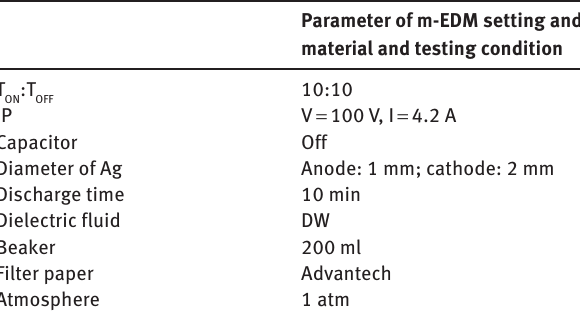
Table 1: The parameter setting for producing nanocomposite metal fluids.